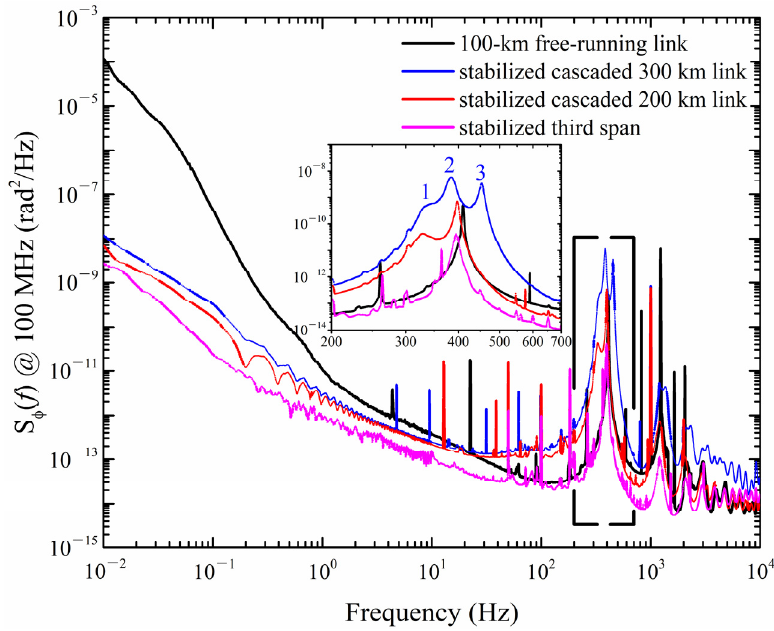
Figure 9. Residual phase noise spectral density of the fiber link measured at 100 MHz.